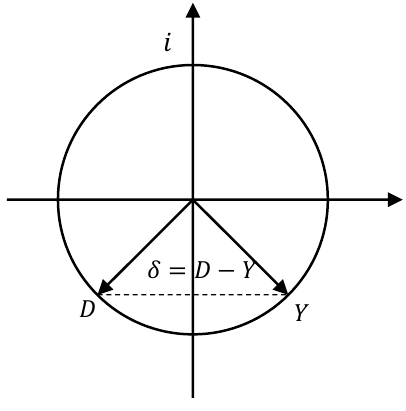
Figure 2. Geometrical interpretation of the continuous MVN activation function.